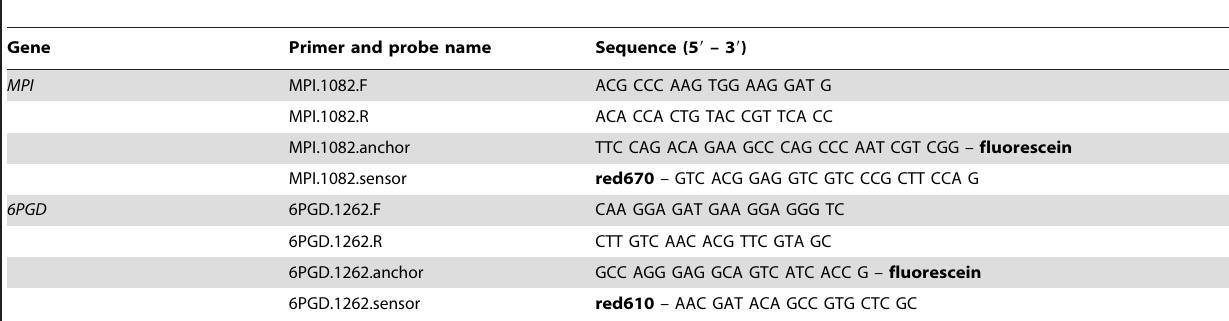
Table 2. Primers and labeled-probes used in the nested real-time PCR assays for MPI and 6PGD genes.